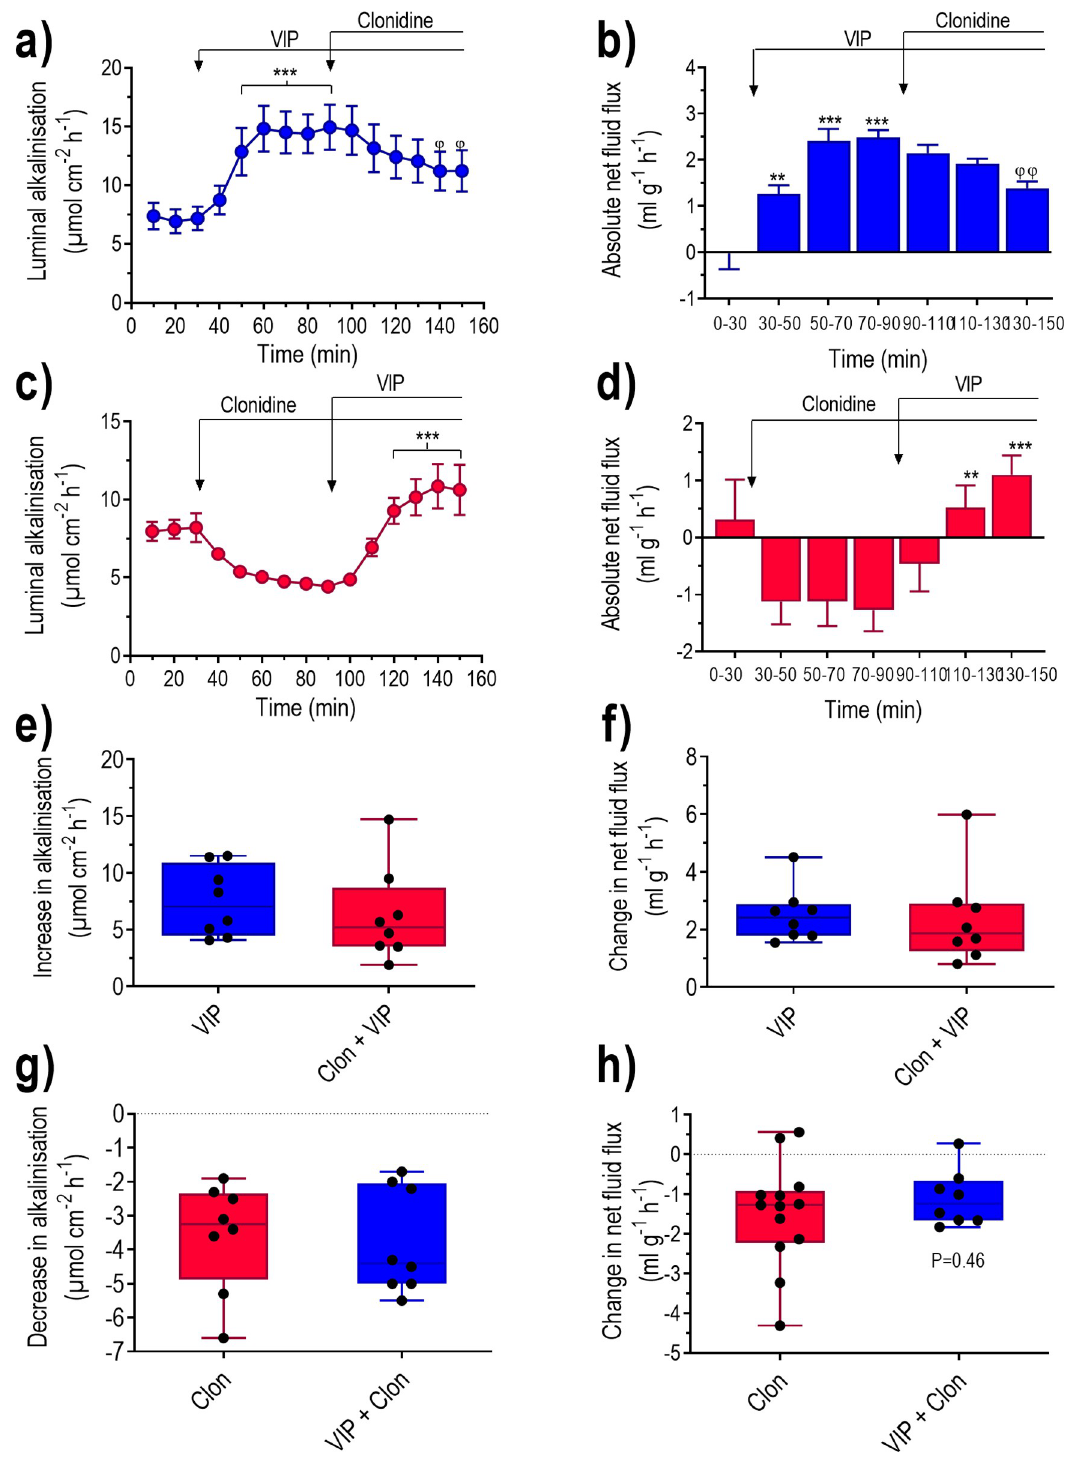
Fig 9. The effects of clonidine administered before and after treatment with vasoactive intestinal peptide (VIP) on fluid flux and luminal alkalinisation in rat duodenum. Duodenum was perfused with isotonic saline for 150 min. Effects on (a and c) luminal alkalinisation and (b and d) transepithelial net fluid flux determined with (a and b) VIP (i.v. 15 μ g kg -1 h -1 ) from 30 min and clonidine (i.v. 10 μ g kg -1 h -1 ) from 90 min, or with (c and d) clonidine from 30 min and VIP from 90 min. The (e) increase in luminal alkalinisation and the (f) change in net fluid flux in response to VIP alone (mean 70–90 min minus 0–30 min) and in